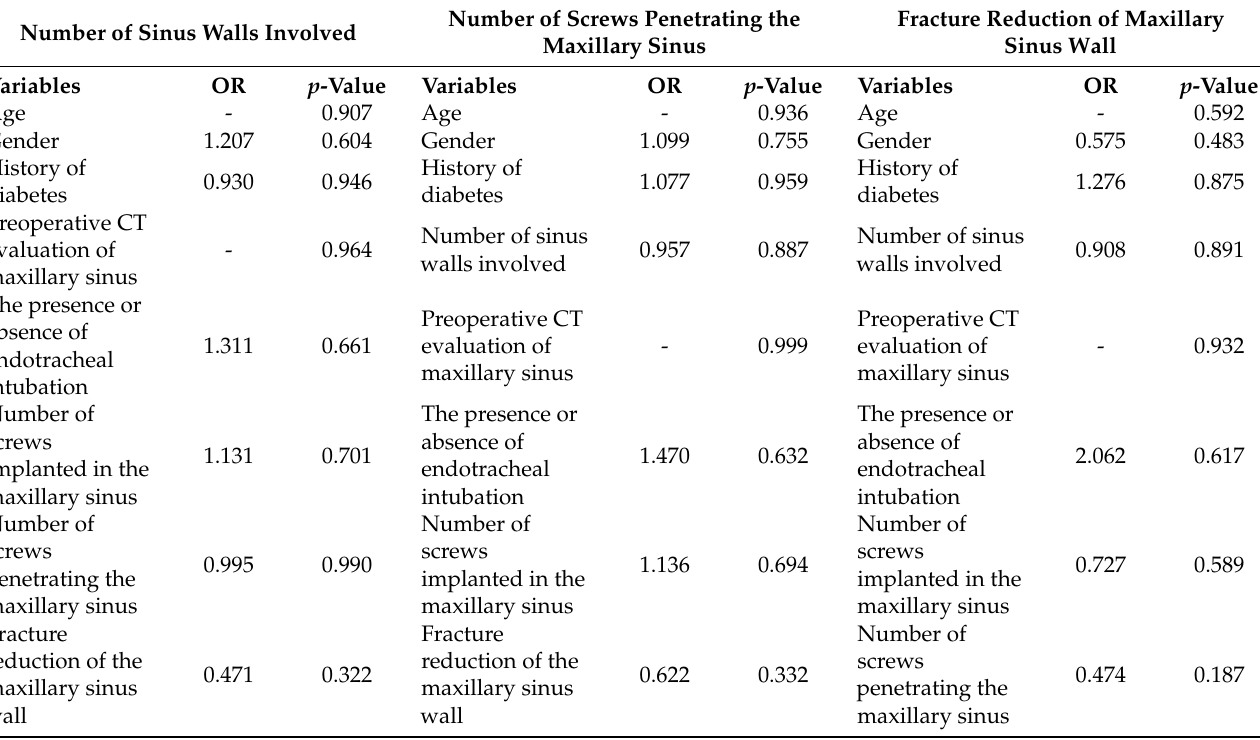
Table 4. Patients’ potential confounding variables in different groups based on potential risk